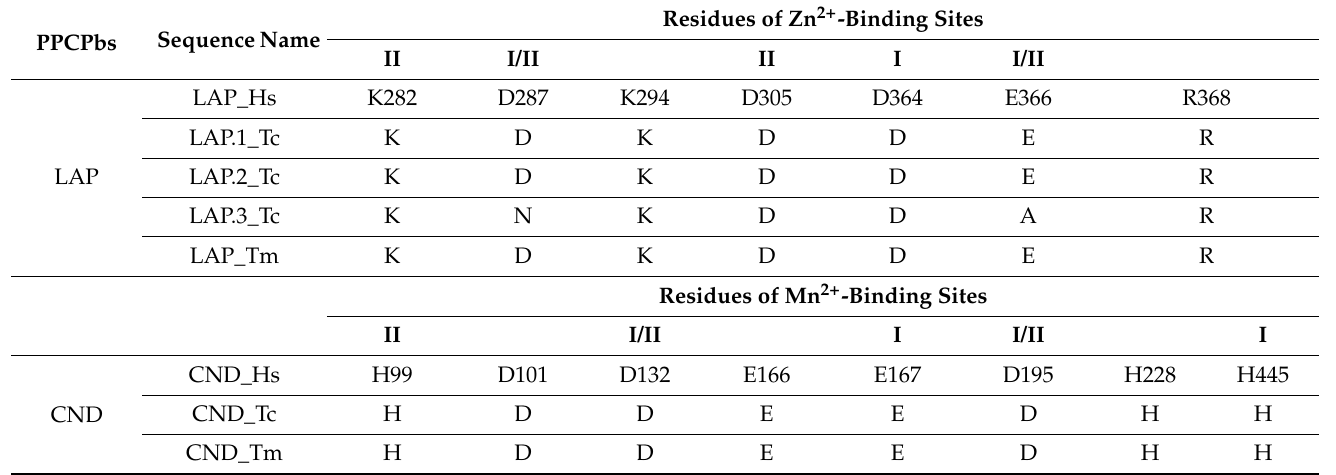
Table 4. General characteristics of the LAP and CND sequences from the M17 and M20